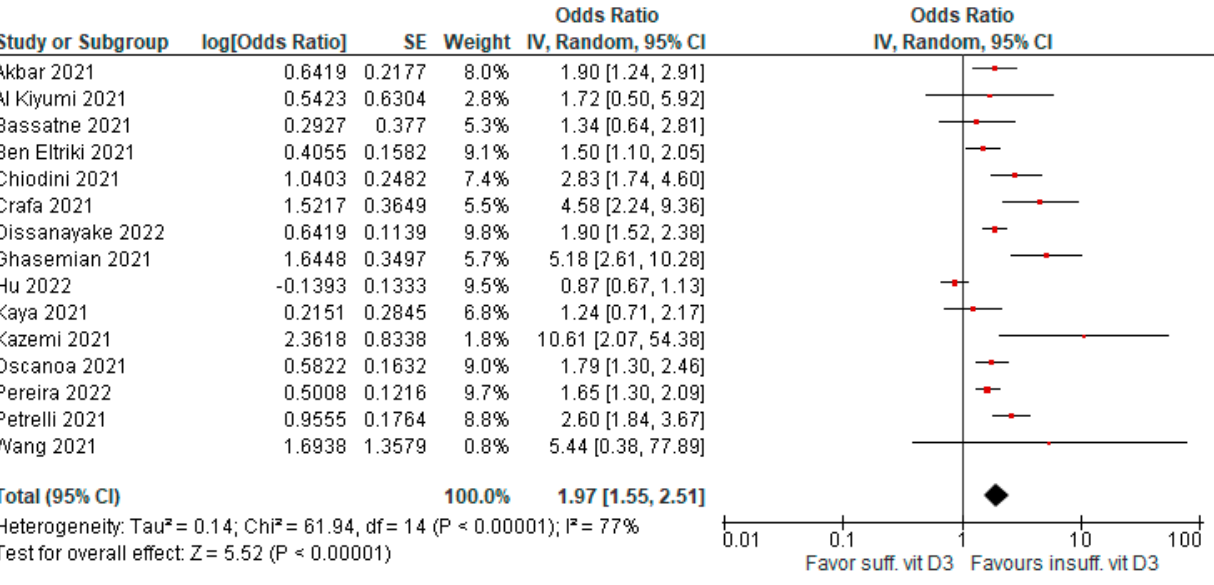
Figure 3. Forest plot showing results for the association of vitamin D3 levels and COVID-19 severity.